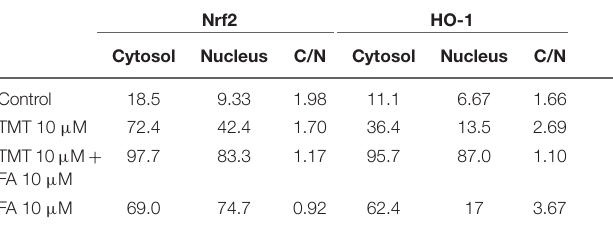
TABLE 1 | Nrf2 and HO-1 fluorescence signals (average optical density values from four independent experiments) in the cytosol and nucleus of SH-SY5Y